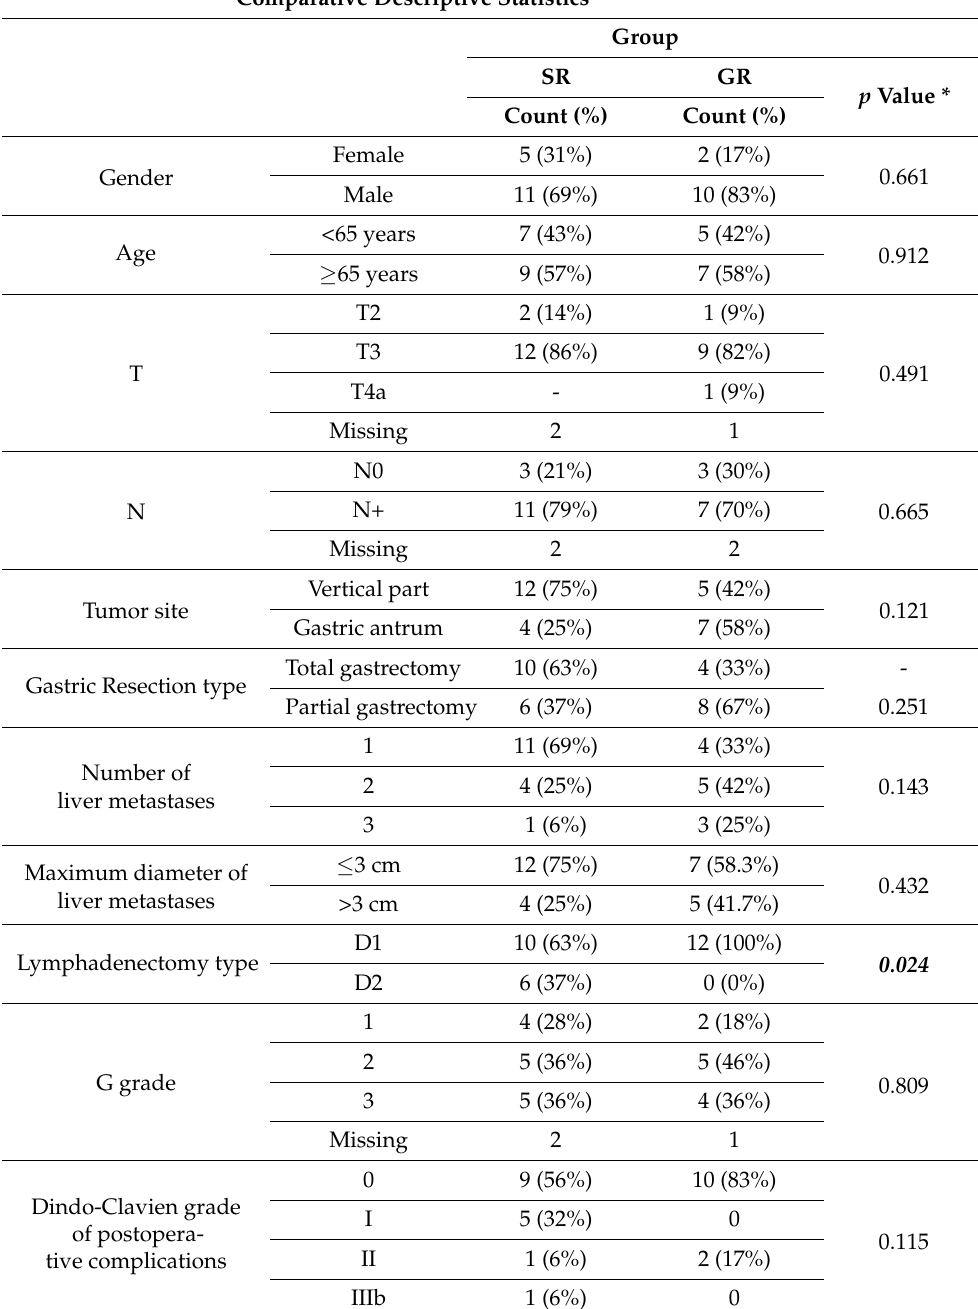
Table 1. Comparative clinico-pathological characteristics between the SR group vs. GR group. Comparative Descriptive